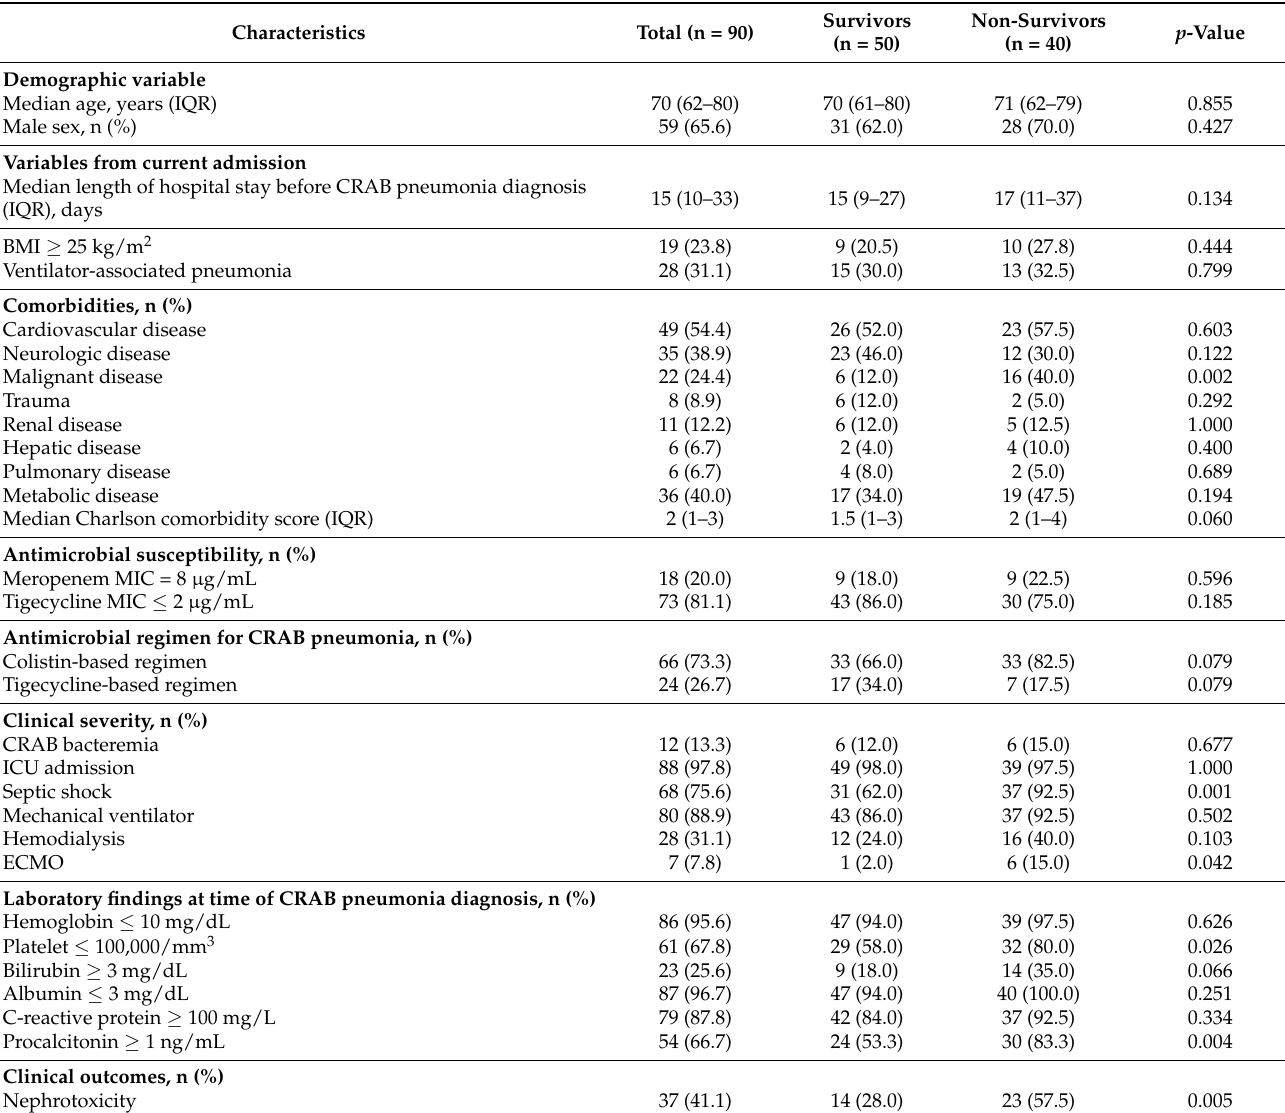
Table 3. Comparison of demographic and clinical characteristics between survivors and non-survivors in patients with carbapenem-resistant Acinetobacter baumannii pneumonia.